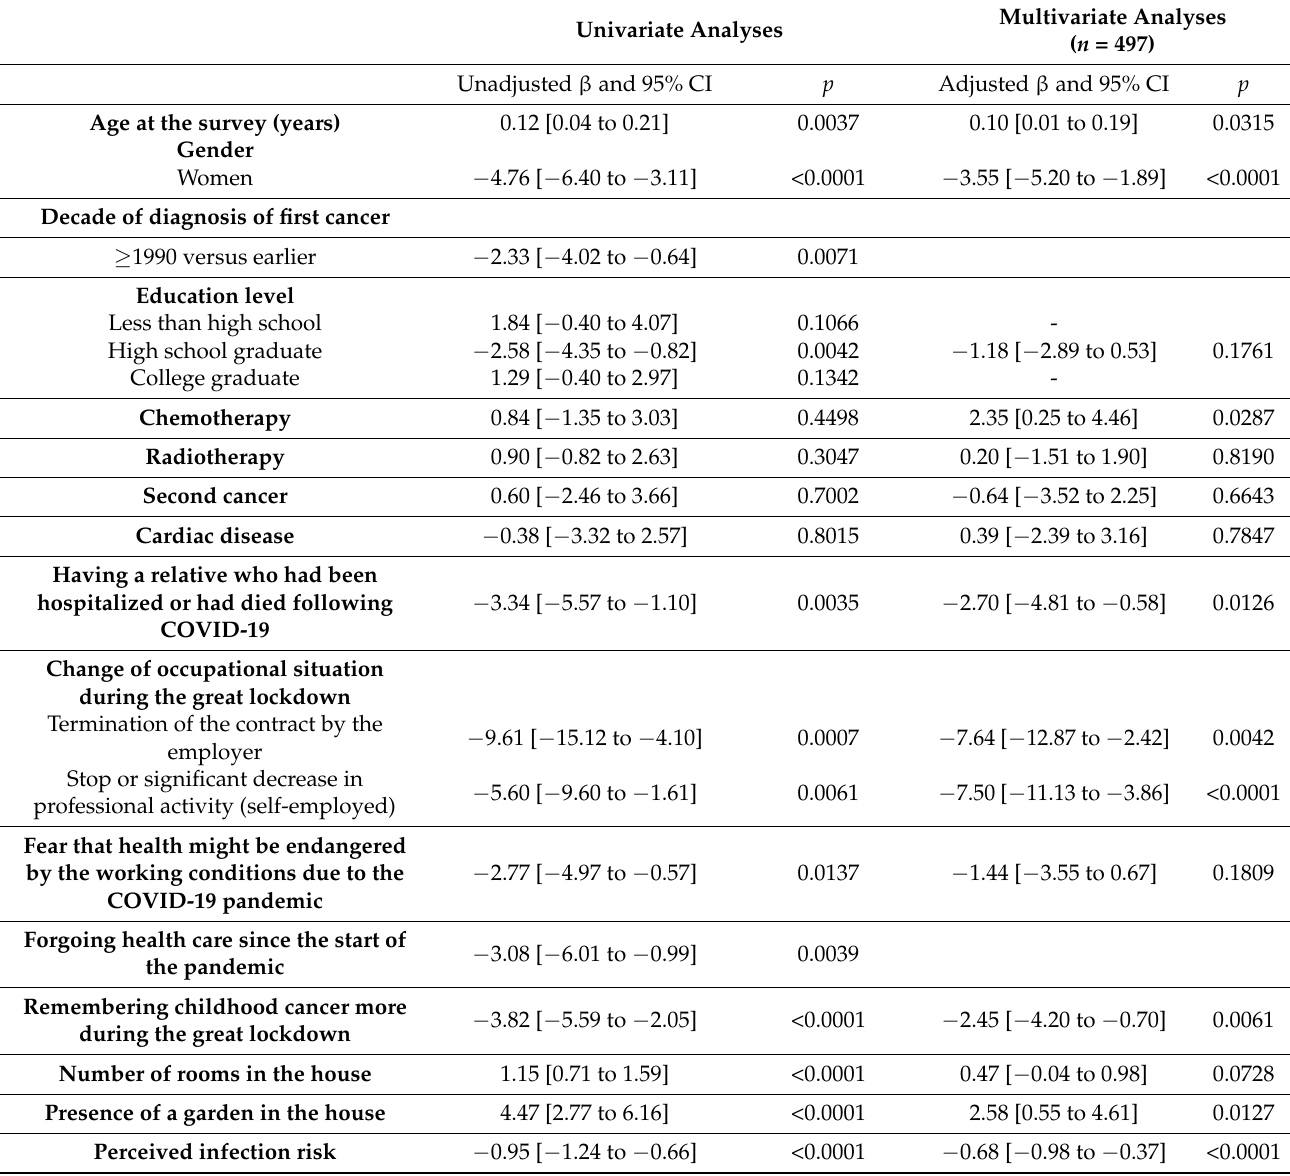
Table 3. Variables and factors associated with the Mental Health Inventory-5 (MHI-5) score. Univariate